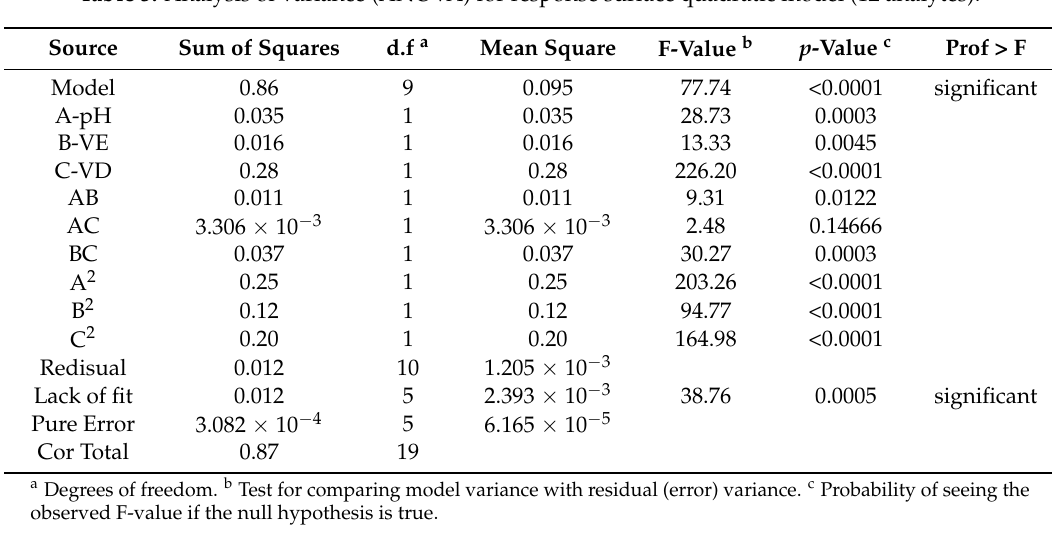
Table 3. Analysis of variance (ANOVA) for response surface quadratic model (12 analytes).